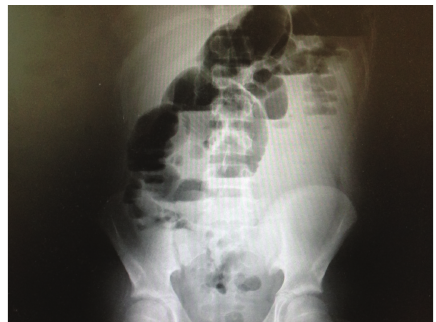
Figure 1: Small bowel loop.